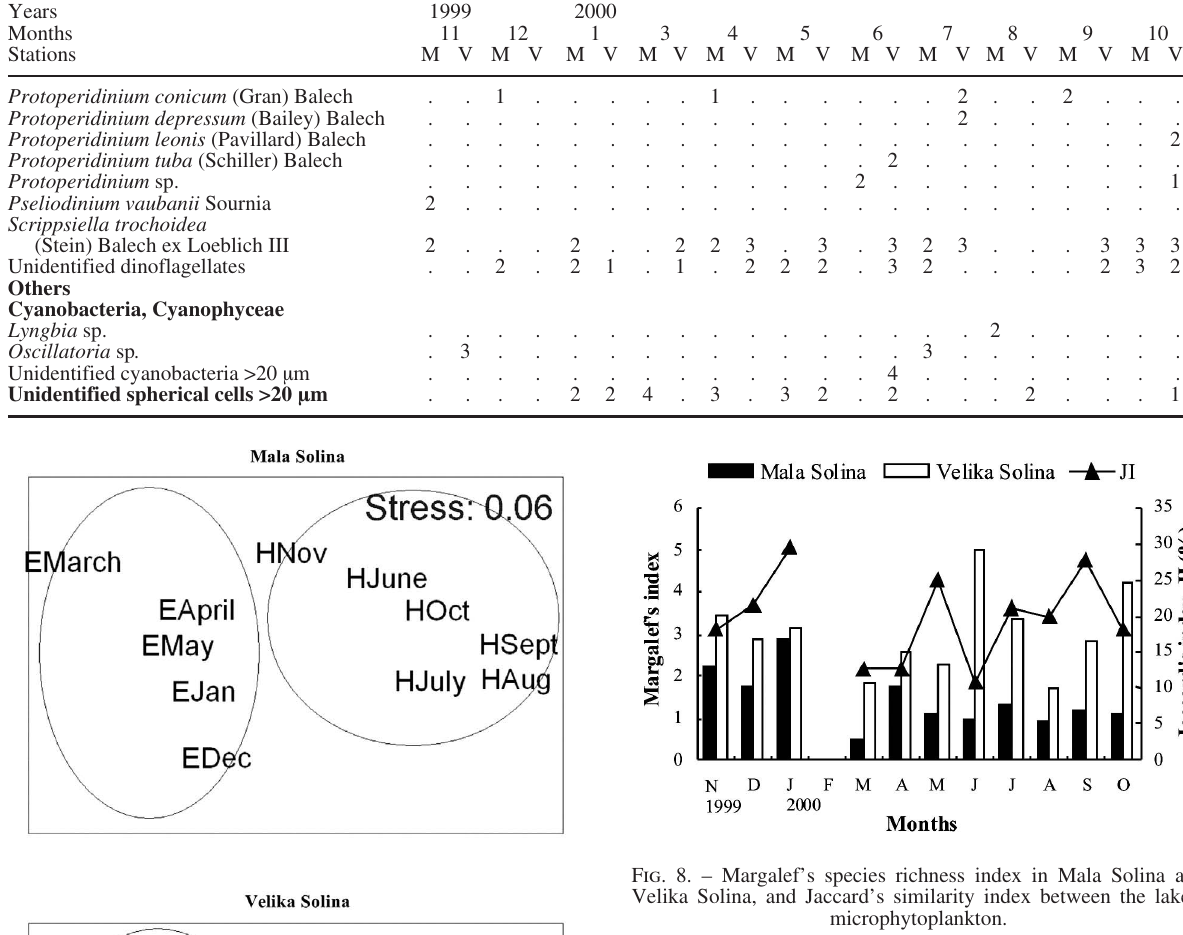
(Table 1). Intense development of this species was found